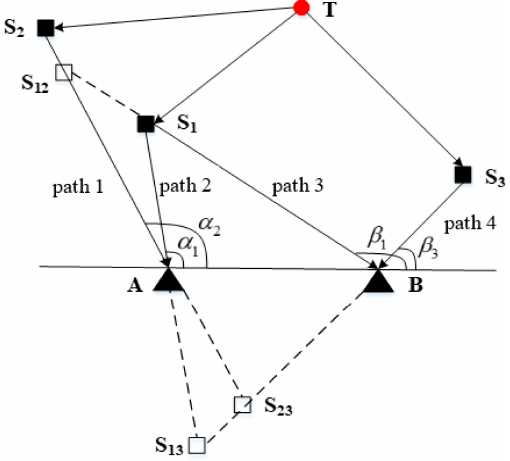
Figure 1. Geometry of one-bounce scattering system model.